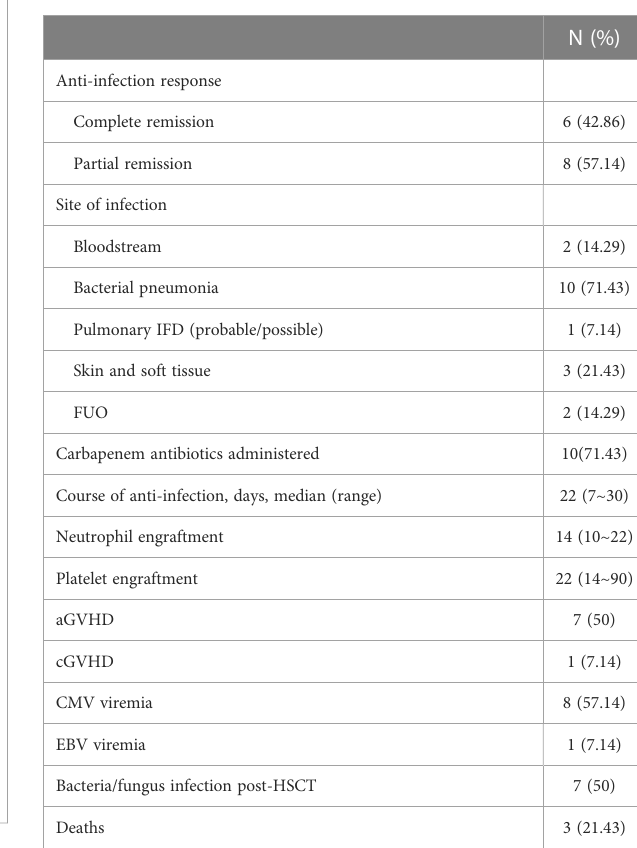
TABLE 5 Clinical information of patients with infections